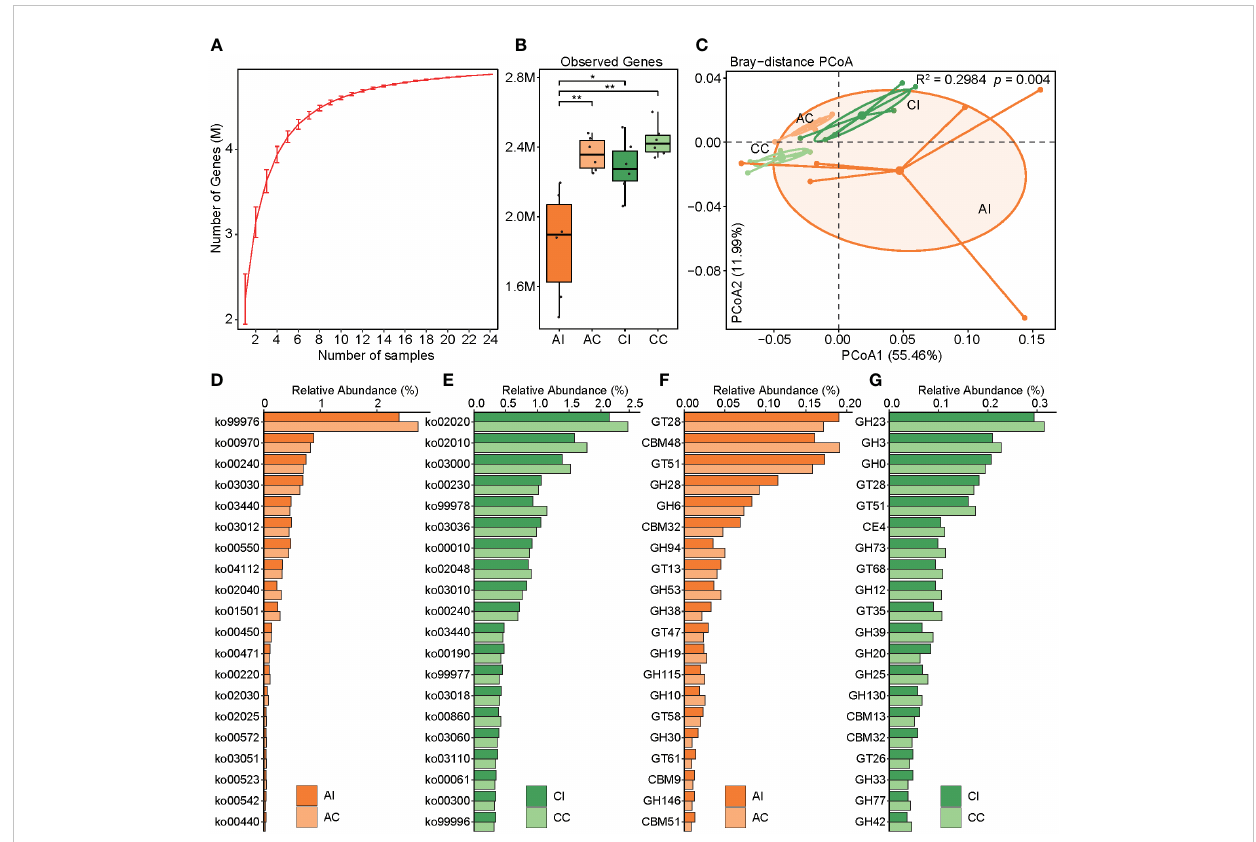
FIGURE 4 Construction of the gene catalog and comparison of the microbial function. (A) Rarefaction curves for the gene number in the gene catalog after 100 random samplings. (B) Comparison of the microbial gene count in the four groups, and asterisks indicate a statistical signi fi cance: * indicates p < 0.05; ** indicates p < 0.01. (C) PCoA based on the Bray – Curtis distance of the KO pro fi le shows the beta diversity of microbial function. Microbial functional differences were veri fi ed by PERMANOVA. (D, E) Bar plots show the relative abundance of the top 20 remarkably different KEGG pathways ( p < 0.05). Deep orange indicates the infected group in the acute period, and light orange indicates control. Deep green indicates the infected group in the chronic period, and light green indicates control. (F, G) Bar plots show the relative abundance of the top 20 remarkably different CAZy family ( p < 0.05). Deep orange indicates the infected group in the acute period, and light orange indicates control. Deep green indicates the infected group in the chronic period, and light green indicates